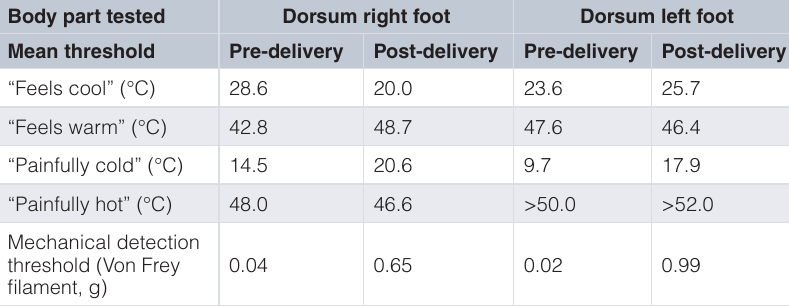
Table 1. Temperature and mechanical thresholds of the dorsum of both feet before and after childbirth (baseline temperature